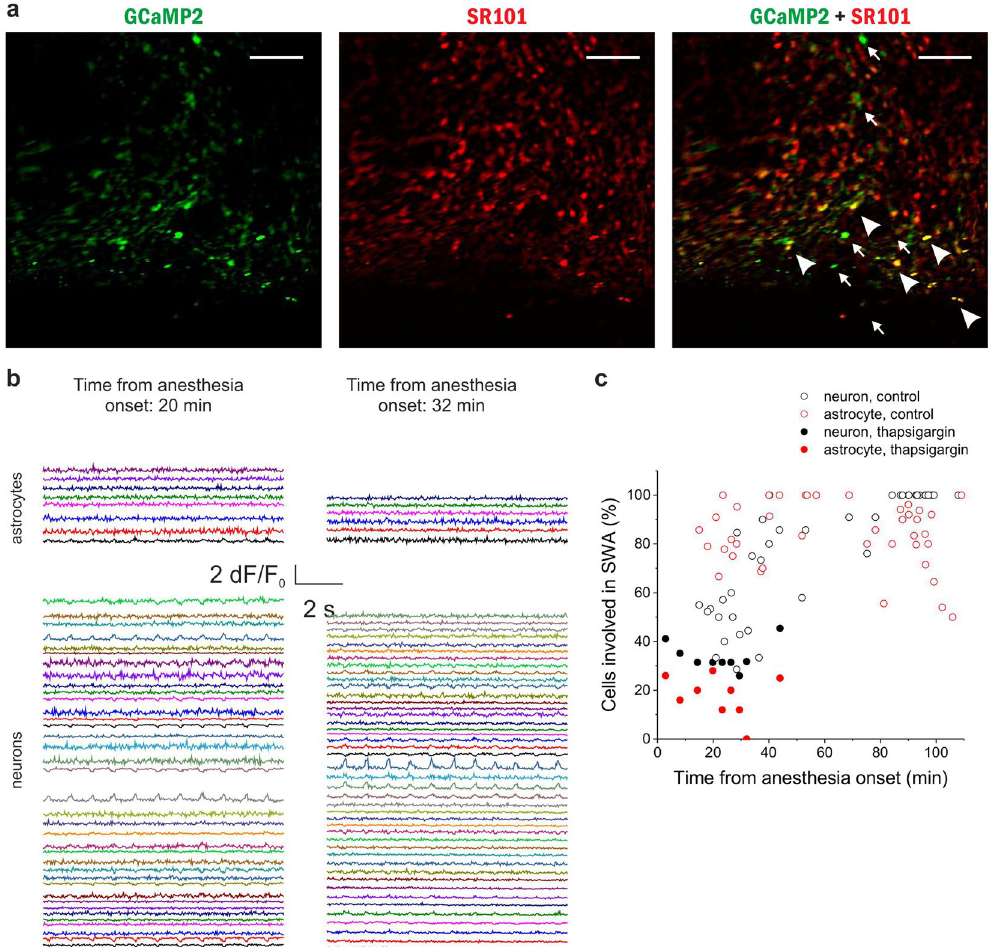
Figure 8. Specific reduction of the astrocytic Ca 2 + transients by thapsigargin inhibits synchronization in both astrocytes and neurons in vivo . ( A ) Expression of GCaMP2 (green), labeling of astrocytes with SR101 (red). Both neurons (some marked by arrows) and astrocytes (some marked by arrowheads) express GCaMP2. Scale bars: 100 µ m ( B ) Left : 10-sec segments of ∆ F/F 0 fluorescent intensity traces of all identified astrocytes (n = 8) and neurons (n = 37) in the imaged area at 20 min following anesthesia. Right: 10-sec segments of ∆ F/F 0 fluorescent intensity traces of all identified astrocytes (n = 6) and neurons (n = 46) in the imaged area at 32 min following anesthesia. Different cells were imaged at 20 and 32 min. Thapsigargin was applied 30 min before the experiment. ( C ) The ratio of astrocytes (red) and neurons (black) showing repetitive, UP state-related Ca 2 + transients in percentage of all astrocytes or neurons, respectively, in the field of view of the same P38 rat in the presence of thapsigargin (solid markers). Individual markers represent data from each 300-sec imaging sessions. Empty markers represent the ratio of astrocytes (red) and neurons (black) showing repetitive, UP state-related Ca 2 + transients in the absence of thapsigargin. Note that large-scale synchronization is inhibited by thapsigargin in both neurons and astrocytes. All data were recorded from the V1 area of a P38 rat (n = 9 imaging session, 300 s